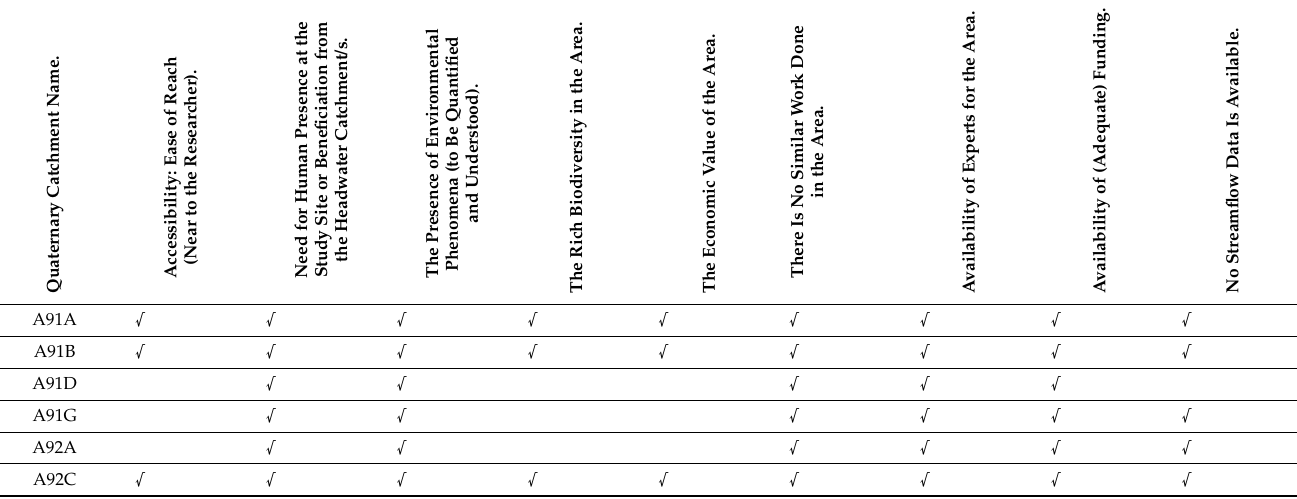
Table 3. The factors that are important to site selection and the possible catchments of study. The tick ( √ ) shows the quaternary catchments that meet the desired factor and could be chosen for